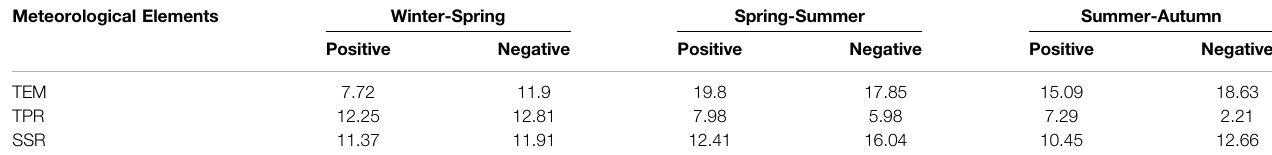
TABLE 2 | Proportion of vegetation areas with vegetation coverage signi fi cantly related to previous-season meteorological elements in China. Meteorological Elements